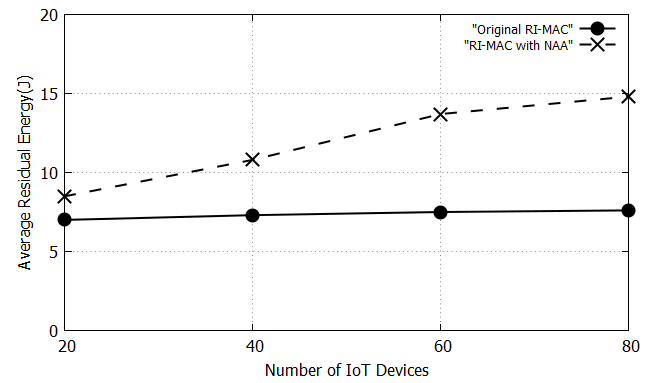
Figure 5. Energy efficiency according to number of